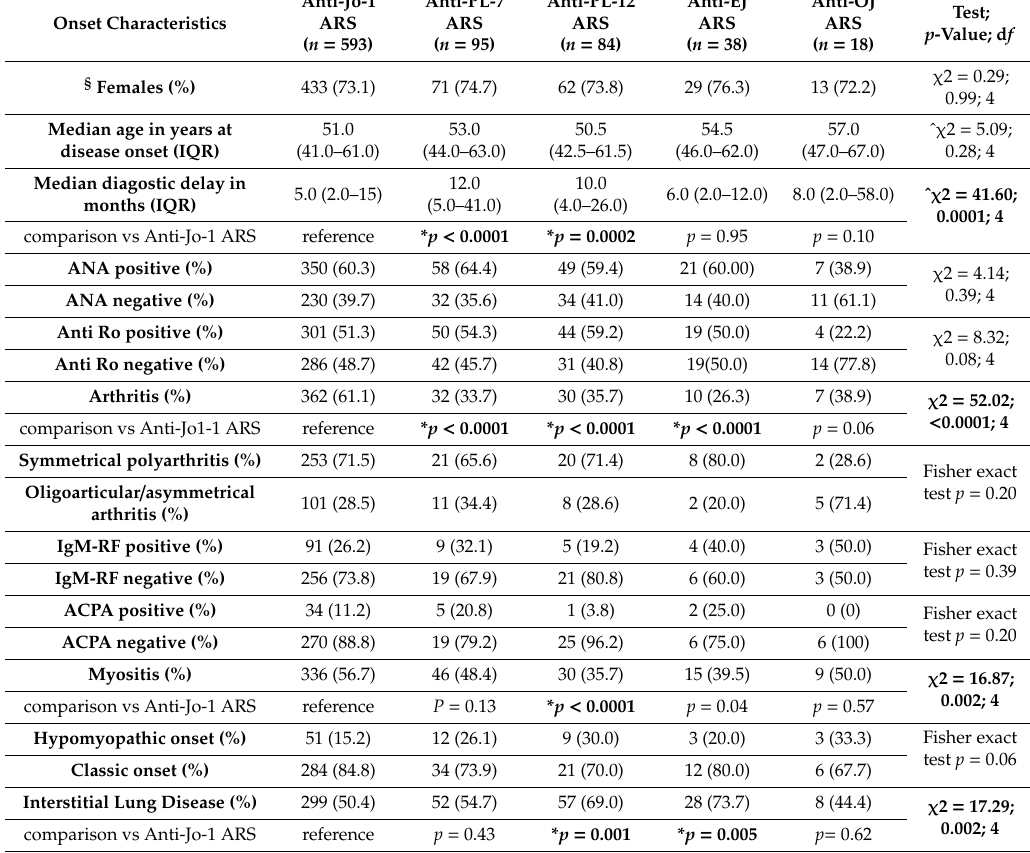
Table 1. Characteristics of included patients at disease